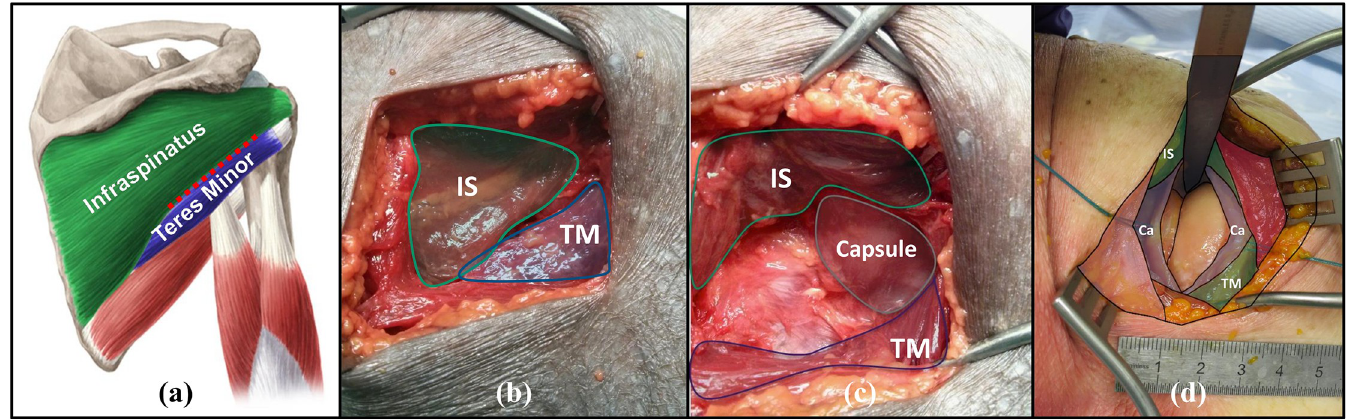
Fig 1. Diagram and photos illustrating the posterior muscle splitting approach. (a) Posterior view of the shoulder with the muscle splitting incision (dashed red line) indicated between the infraspinatus (IS) (green) and teres minor (TM) (blue). (b) Photograph following initial skin incision with shaded regions indicating IS & TM muscle bellies. (c) Photograph of split and retracted IS & TM muscle bellies with joint capsule (Ca) also shaded. (d) Photograph showing incised capsule with articular surfaces visible within the joint.